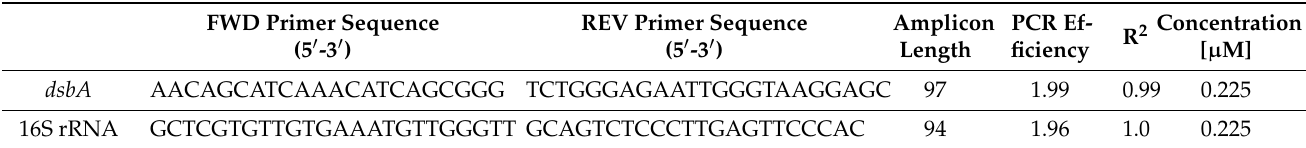
Table 6. Primers used for